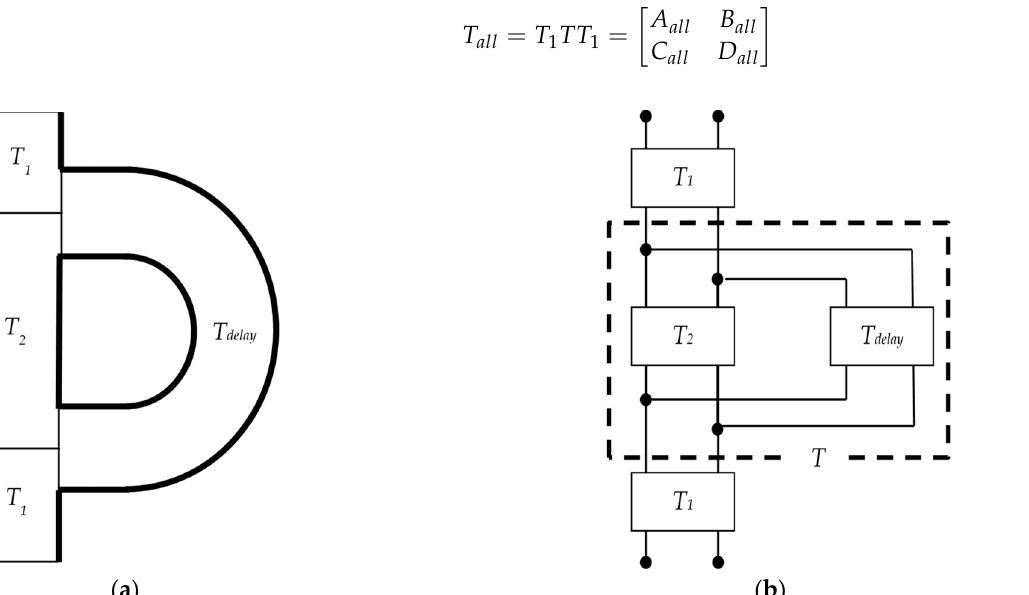
Figure 7. Acoustic elements and equivalent circuit of an interference silencer: ( a ) division into acous- tic elements and ( b ) equivalent circuit. acoustic elements and ( b ) equivalent